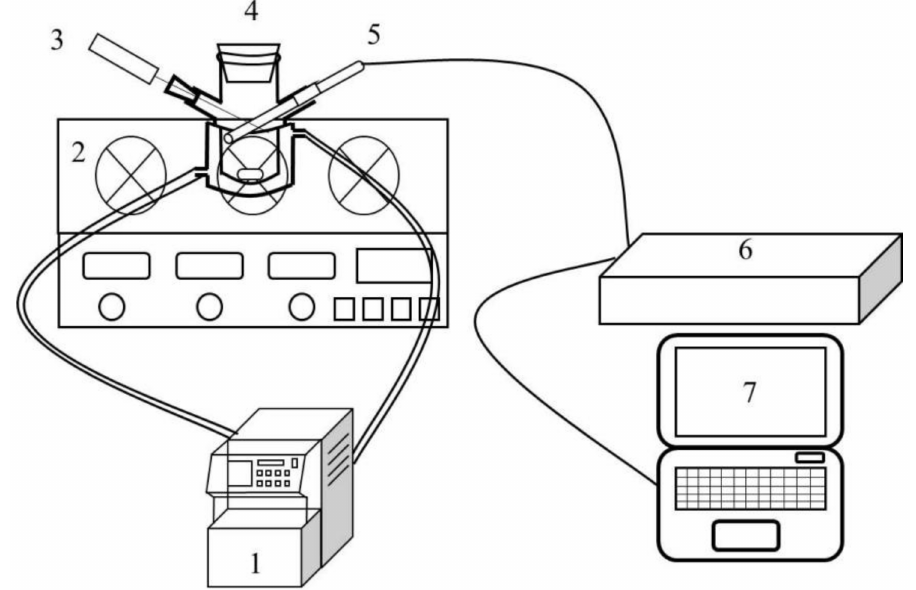
Figure 1. Metastable zone determination experimental flow chart ( 1 : cooling circulating water machine, 2 : digital magnetic stirrer, 3 : digital thermometer, 4 : crystallizer, 5 : FBRM probe, 6 : FBRM workstation, 7 :